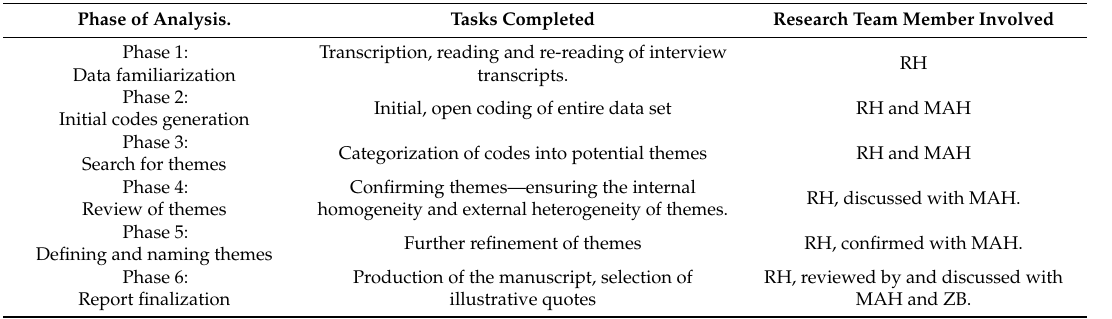
Table 1. Data analysis process.